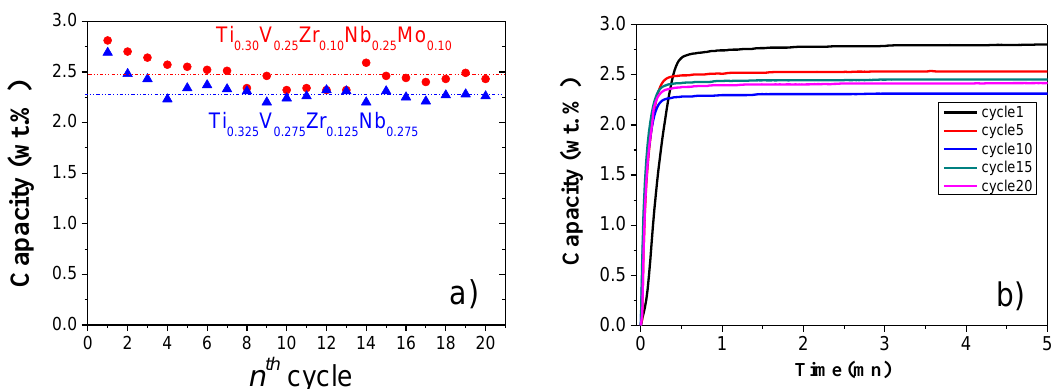
Figure 8. ( a ) Hydrogen absorption capacity during 20 cycles for Ti 0.30 V 0.25 Zr 0.10 Nb 0.25 Mo 0.10 and Ti 0.325 V 0.275 Zr 0.125 Nb 0.275 alloys. ( b ) Hydrogen absorption kinetic curves at room temperature for Ti 0.30 V 0.25 Zr 0.10 Nb 0.25 Mo 0.10 during 20 cycles.